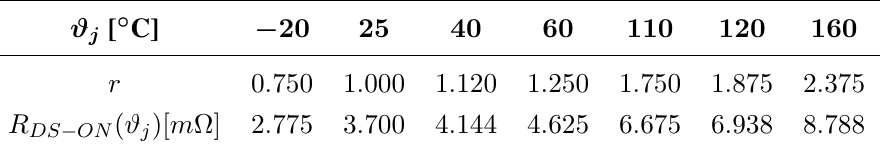
Figure 3. Resistance R as a function of junction temperature # DS (cid:0) ON Table 1. Points extracted from the data-sheet.